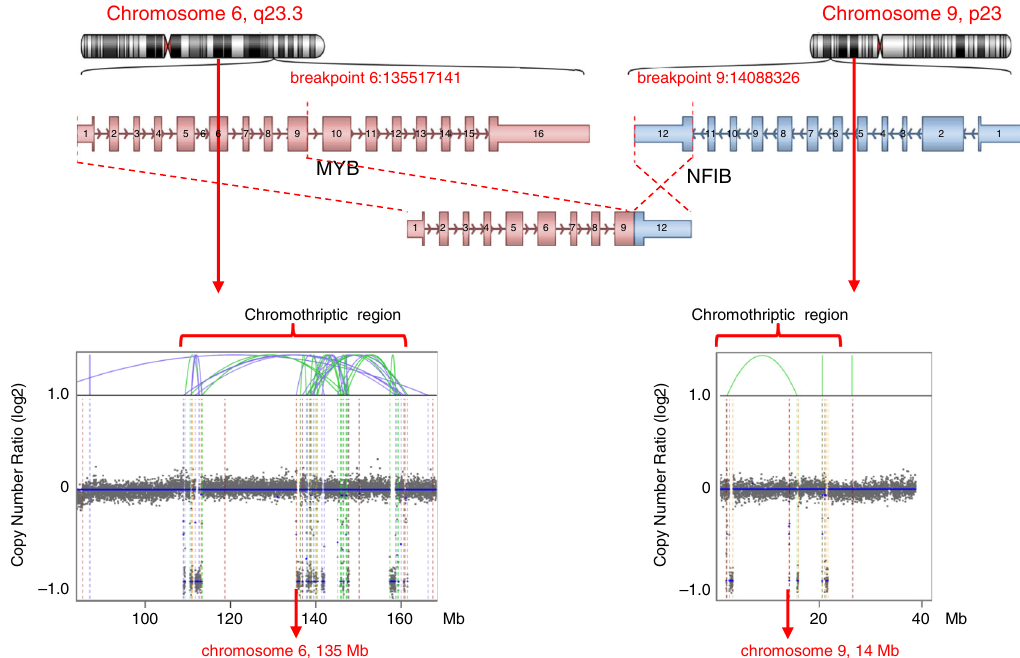
Fig. 4 Gene fusions generated by chromothriptic events. a Tumours with chromothripsis have more gene fusions per structural variant. Regression analysis for the number of fusions depending on the number of structural variants in tumours with or without chromothripsis (see Supplementary data 4 for all parameters of the regression analyses). b Chromothripsis generates clinically relevant gene fusions, as illustrated with the MYB – NFIB fusion, which drives tumour development in adenoid cystic carcinoma. Blue lines indicate inversions, green lines indicate break ends, brown lines indicate translocations and orange lines indicate copy-number